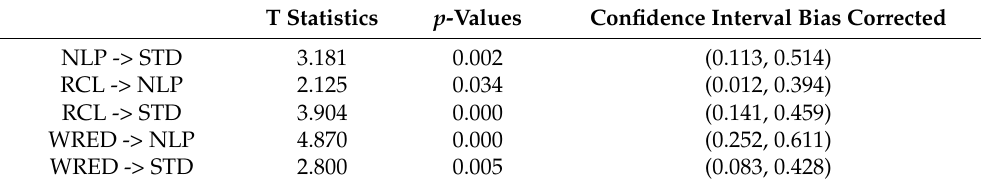
Table 5. The bootstrapping